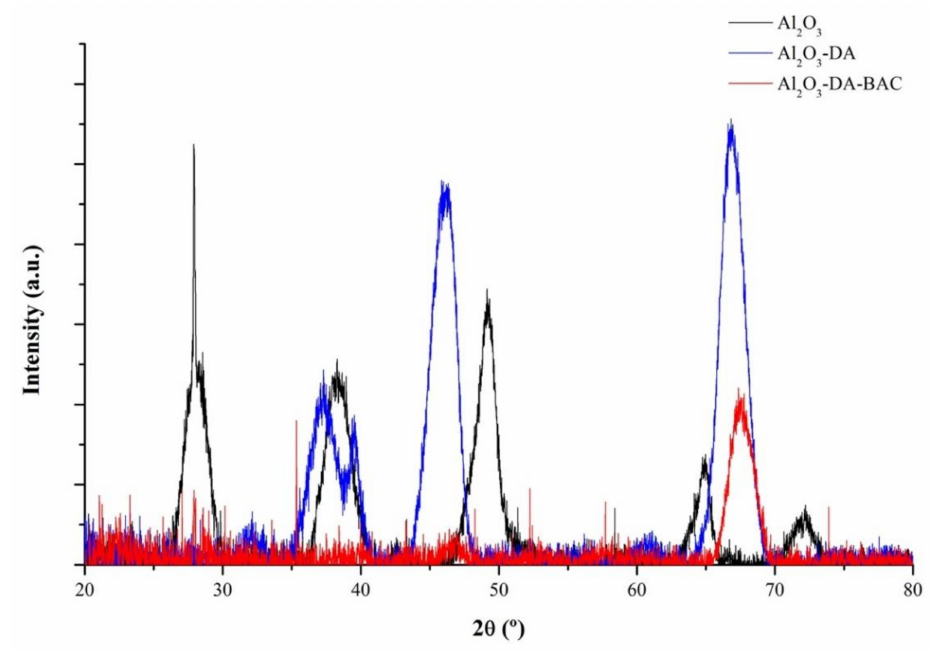
Figure 3. X-ray diffraction (XRD) pattern of functionalized and Al 2 O 3